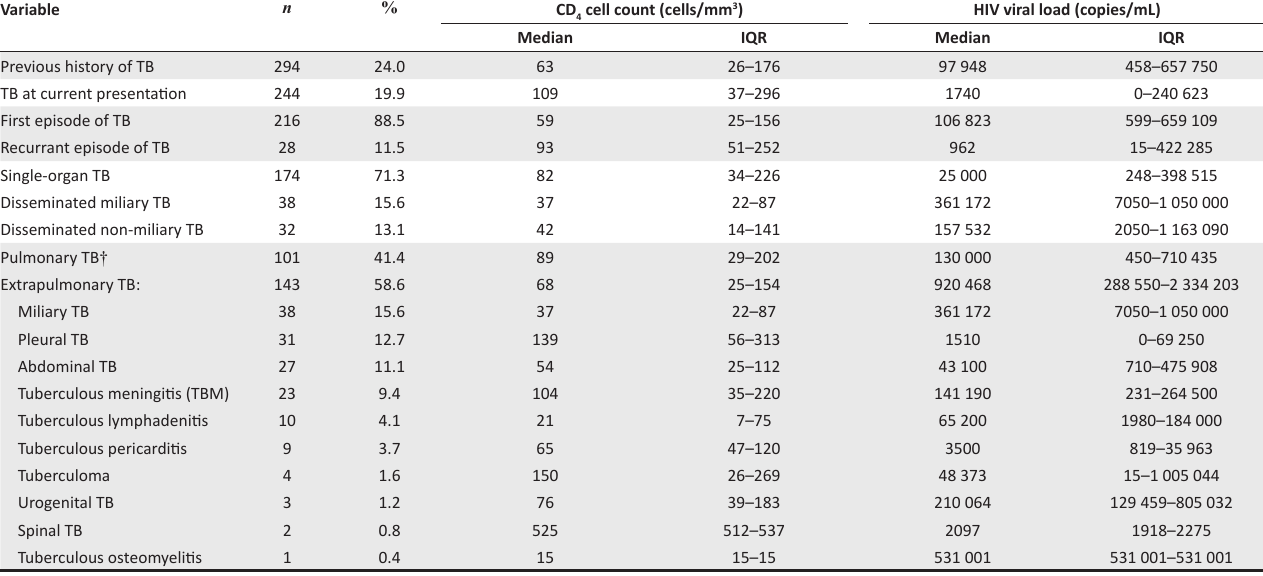
TABLE 3: Description of tuberculosis history and presentation amongst study